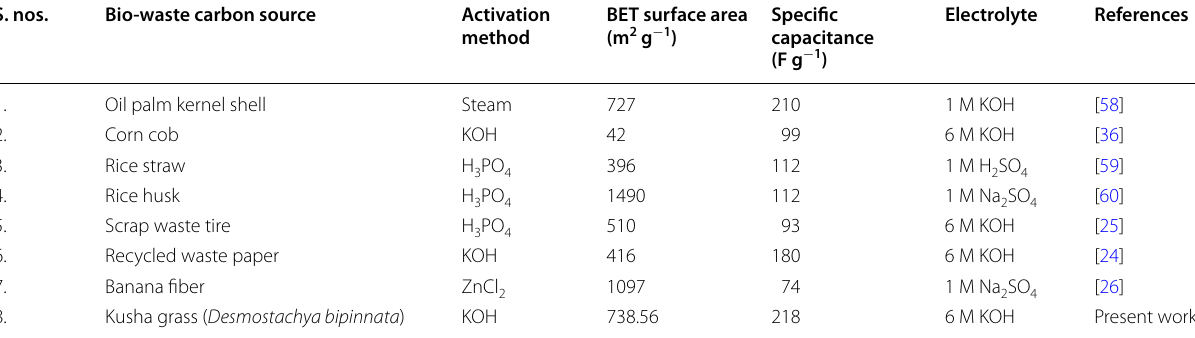
Table 1 Comparison of the present work with other related works based on different natural bio-waste precursors S.